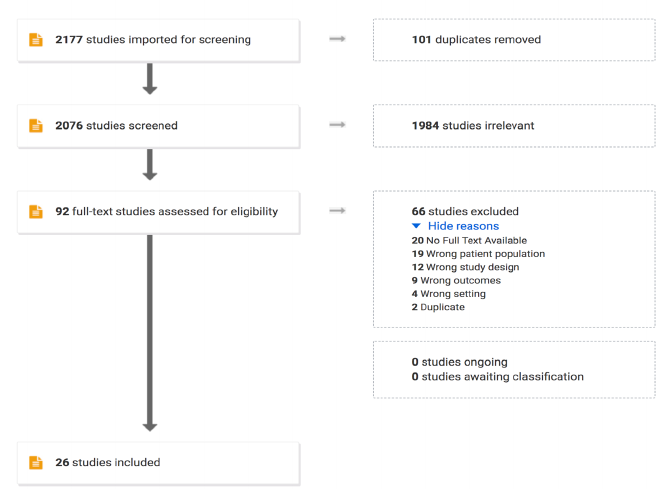
Figure. PRISMA diagram details our search and selection process applied during systematic literature search and critical review. PRISMA, Preferred Reporting Items for Systematic